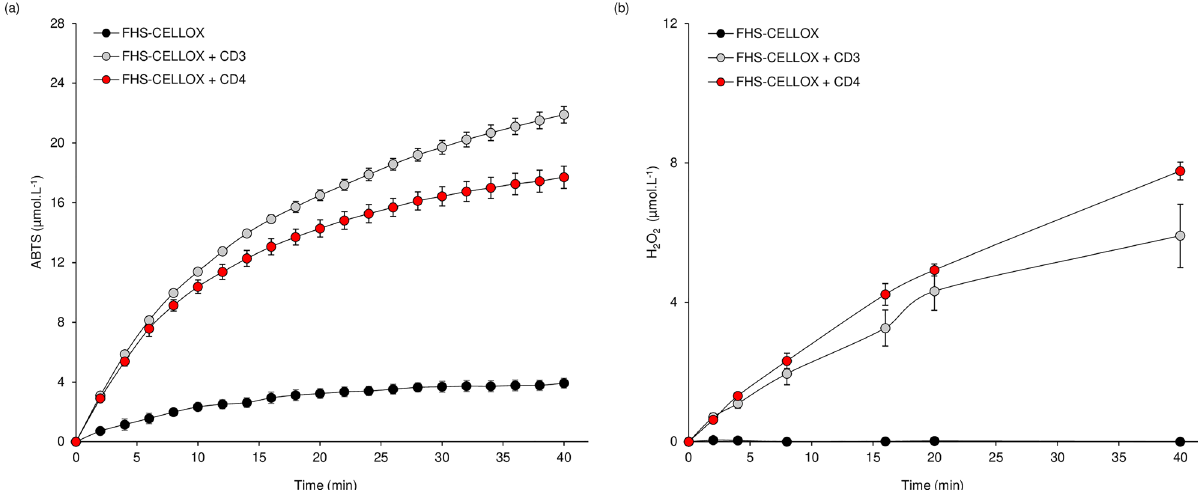
Figure 3. Scavenging activity of FHS-CELLOX and short CD-oligomers towards the radical cation ABTS ·+ . ( a ) Production of ABTS (µmol.L −1 ) over time at pH 5.0 by the activity of FHS-CELLOX (16 nM) using equimolar amounts (15 µM) of CD3 and CD4 in the presence of ABTS ·+ -ABTS mixture (90–20 µM). ( b ) Production of H 2 O 2 (µmol.L −1 ) over time at pH 5.0 by the activity of FHS-CELLOX (16 nM) using equimolar amounts (15 µM) of CD3 and CD4. Values are mean ± SD (N = 3). [ ABTS 2,2’-azino-bis (3-ethylbenzothiazoline-6- sulfonic acid), CD4 cellotetraose, CD3 cellotriose, FHS-CELLOX flag-his-sumoylated to counter-oxidize the scavenged ABTS ·+ by consuming the H 2 O 2 produced with the different OSOX/oligomer combinations (Fig. 1b) 13 . In the presence of HRP, the ABTS ·+ -scavenging activity of both FHS-OGOX1/OG3 and FHS-OGOX1/OG4 combinations remained the same, whereas an opposite activity (production of ABTS ·+ ) was observed for the FHS-OGOX1/OGs pair (Fig. S3). Based on this result (Fig. S3), the presence of H 2 O 2 was detected only in the reaction containing FHS-OGOX1/OGs, i.e. the combination characterized by the lowest ratio between ABTS ·+ -scavenging activity (Fig. 2a) and H 2 O 2 -producing activity (Fig. 2b). The ABTS‑oxidizing activity of a fungal laccase is counteracted by the activity of OSOXs on short oligosaccharides. To evaluate whether the scavenging activity of OSOXs can counteract the oxidiz- ing activity of microbial ligninases, the laccase from Trametes versicolor was assayed in the presence of different FHS-OSOX/oligomer combinations by using ABTS as substrate. It is worth noting that the oxidation of ABTS by laccase, differently from HRP, is not H 2 O 2 -dependent. The ABTS-oxidizing activity of laccase was strongly reduced by the FHS-CELLOX/CD3 combination and, at lesser extent, by the FHS-CELLOX/CD4 and FHS- OGOX1/OG4 combinations, whereas the FHS-OGOX1/OGs combination was ineffective (Fig. 4). Indeed, this result clearly demonstrated that the scavenging activity of OSOXs towards the laccase-catalyzed oxidation of ABTS required the presence of oxidizable short oligosaccharides. Differently from the ABTS ·+ -reduction assay, the lower amount of ABTS ·+ (0–9 µmol.L −1 , Fig. 4) as contained in the ABTS-oxidation assay allowed a direct measurement of H 2 O 2 by using the xylenol orange. In the presence of laccase, the (negligible) scavenging activity of the FHS-OGOX1/OGs combination did not have any impact on the production of H 2 O 2 whereas the strong scavenging activities of both FHS-OGOX1/OG4 and FHS-CELLOX/CD3 combinations were associated with decreased levels of H 2 O 2 (Fig. S4). Also in this case, higher scavenging activities were related to lower levels of H 2 O 2 and vice versa. In conclusion, the OSOX activity on short oligosaccharides scavenged the radical cation ABTS ·+ (Fig. S2) with an efficiency dependent on the type and length of each oxidized oligosaccharide (Figs. 2, 3, 4) and at the expense of the H 2 O 2 as produced from their oxidation (Figs. S3, S4). The oxidation rate of CD3 is higher in the presence of ABTS ·+ .